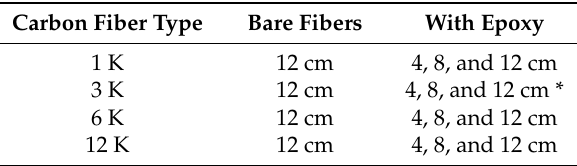
Table 1. Summary of tensile test